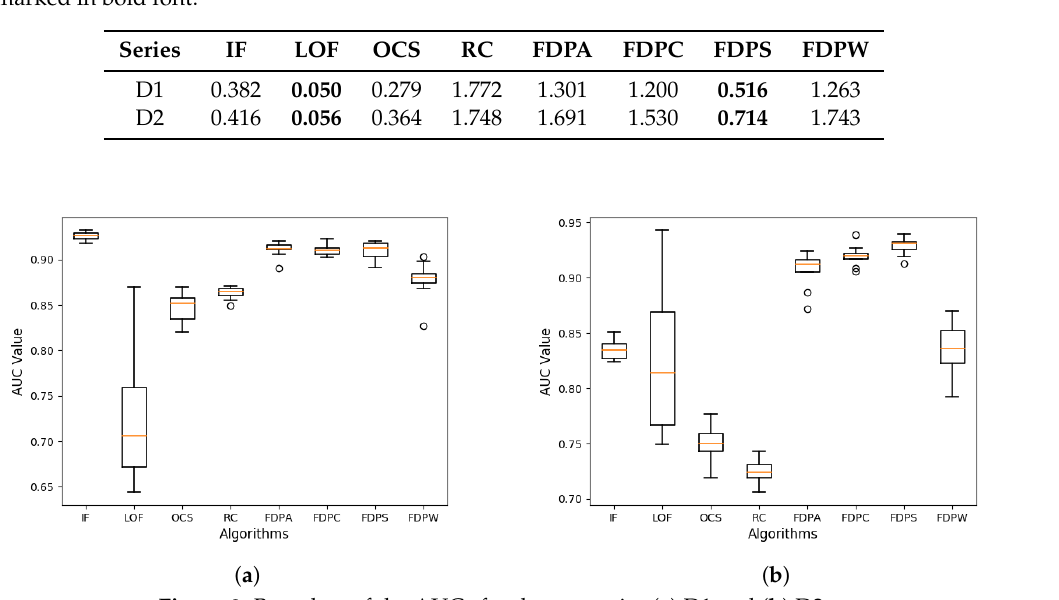
Figure 9. Box plots of the AUCs for dataset series ( a ) D1 and ( b ) D2.